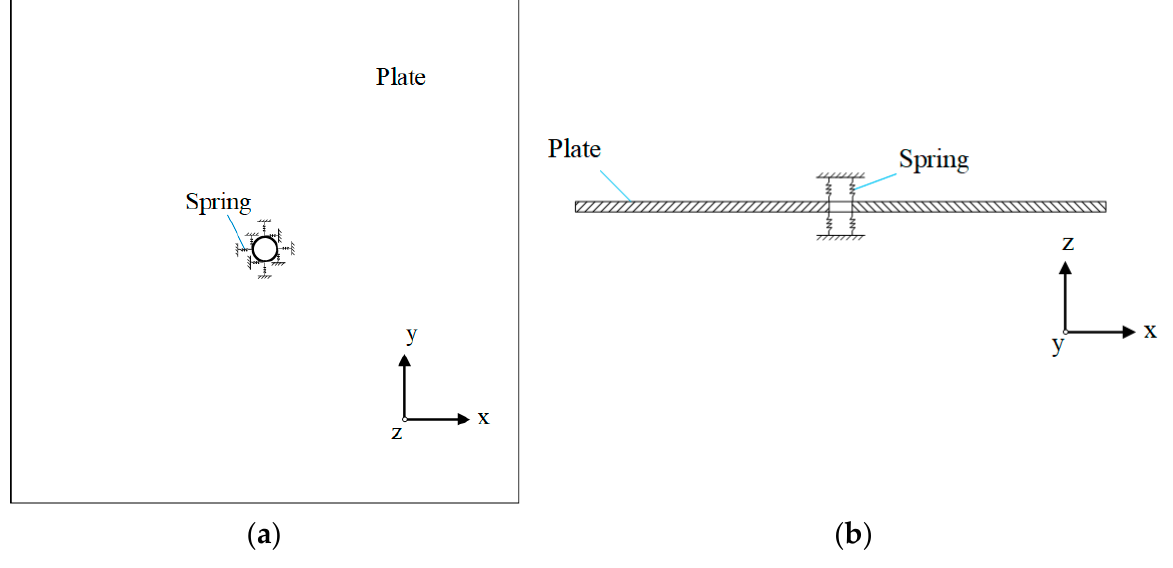
Figure 10. Schematic diagrams of the support springs. ( a ) x- and y-direction springs and ( b ) z-direction springs.